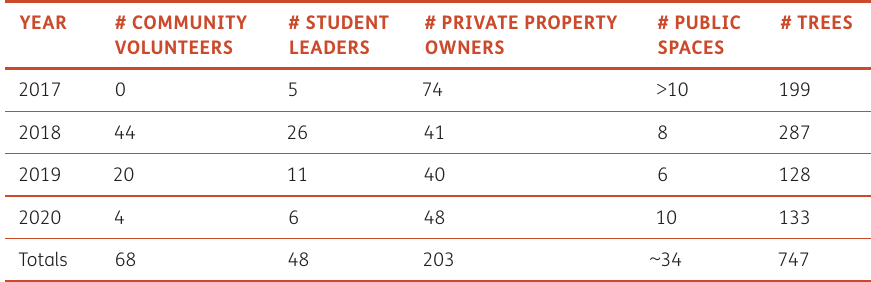
Table 1 Summary of Apple Blitz participants, sites, and trees. Note: Summary of community data collectors and undergraduate student apple explorers, property types, and number of trees sampled.